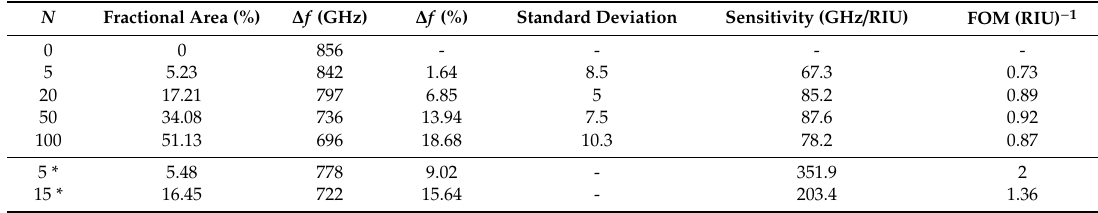
Table 1. Comparison of the most relevant performance parameters of the labyrinth metasurface structure, for di ff erent numbers of fungi deposited on top. The cases highlighted with (*) correspond to fungi placed in the regions of maximum field